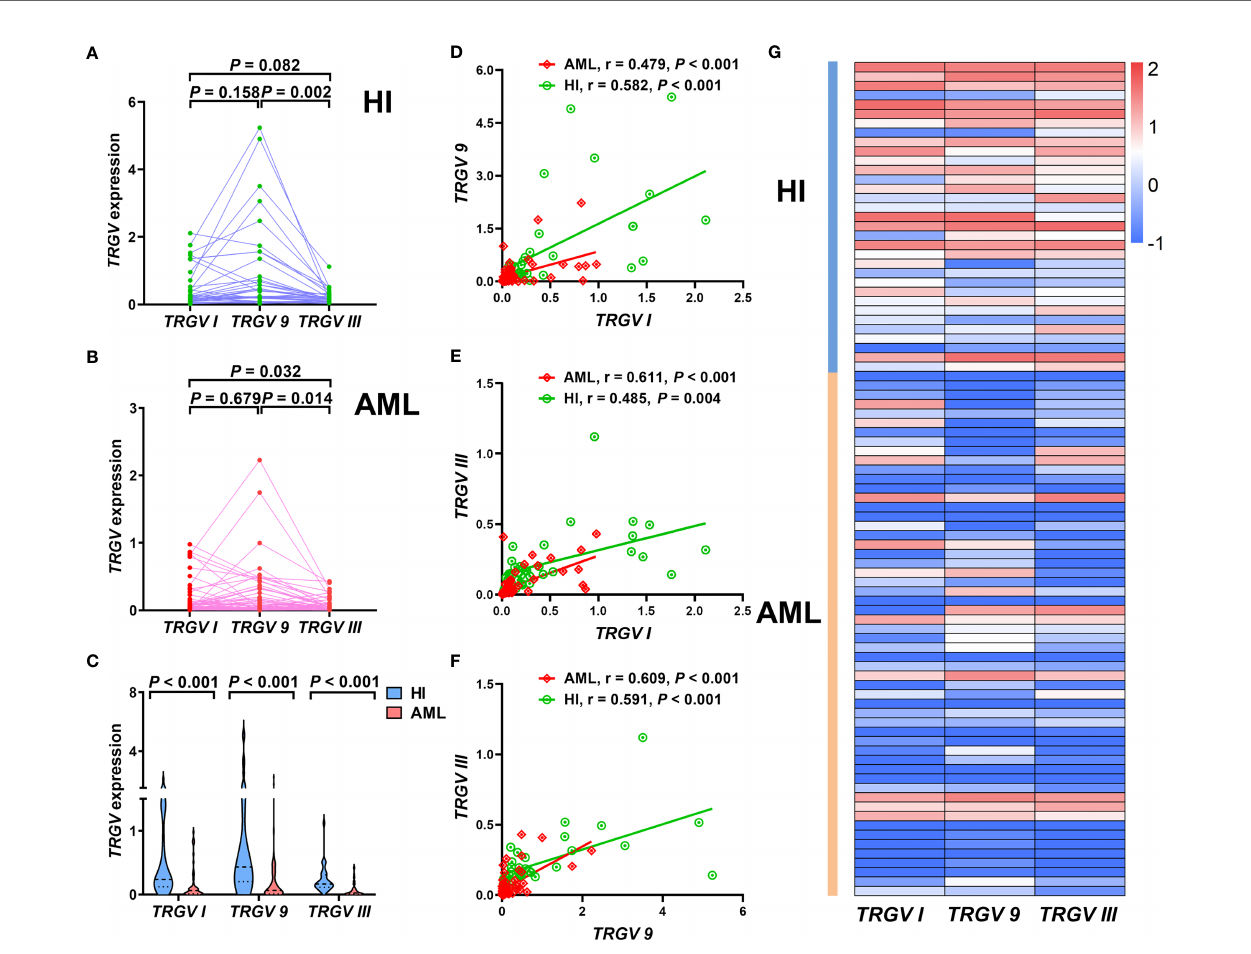
FIGURE 3 | Pattern of expression levels of three TRGV subfamilies in gd T cells from 33 cases with healthy individuals and 56 cases with AML (using the Mann Whitney test) (A – C) . Correlations among three TRGV subfamilies in 33 healthy individuals and 56 patients with AML (using the Pearson correlation analysis) (D – F) . Heatmap representing the expression levels of three TRGV subfamilies in 33 healthy individuals and 56 patients with AML (G)